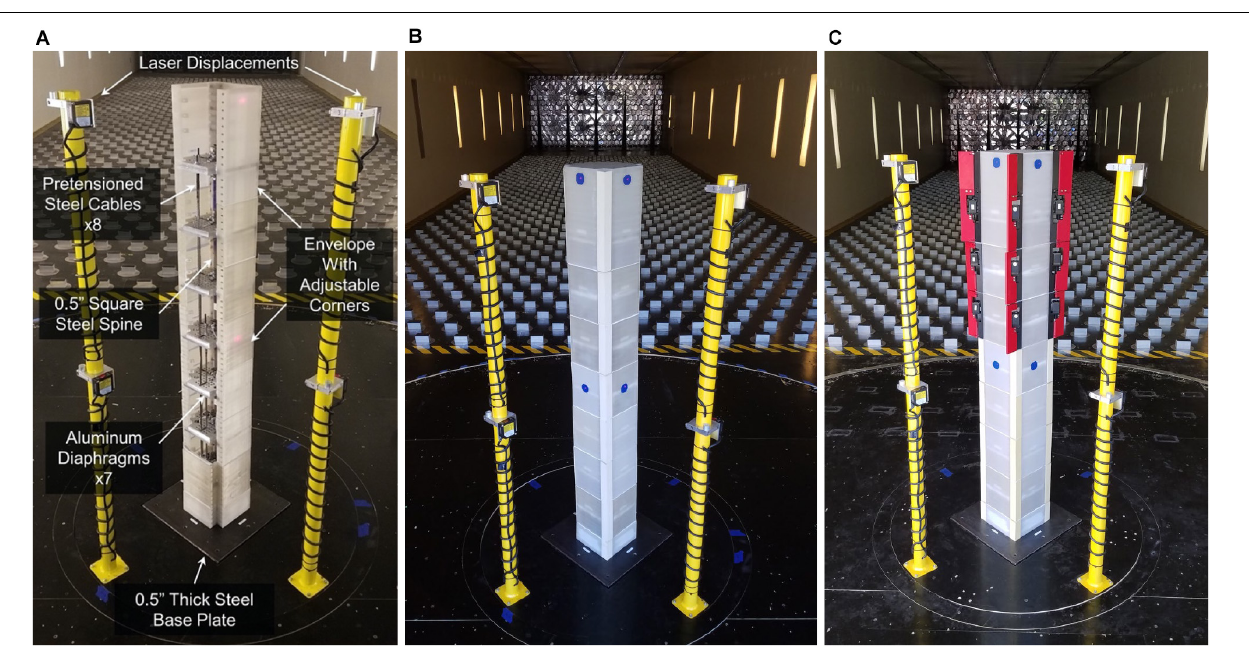
FIGURE 5 | 1.5 m tall multi-degree-of-freedom aeroelastic model: (A) inner mechanics exposed, (B) enclosed model without fins, and (C) enclosed model with